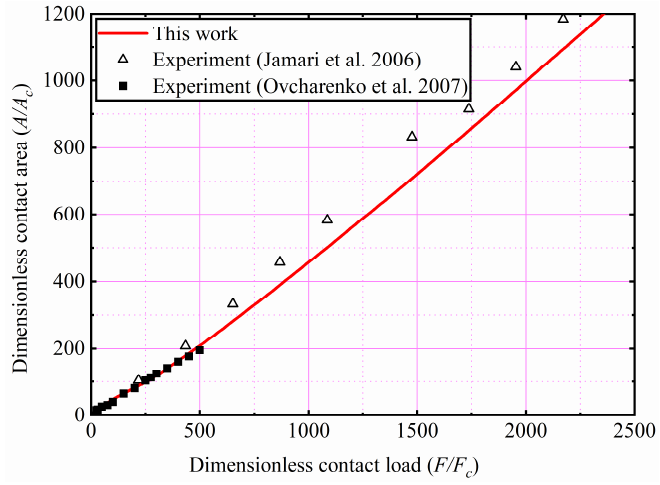
Figure 15. Comparison with experimental results for the stainless-steel and copper